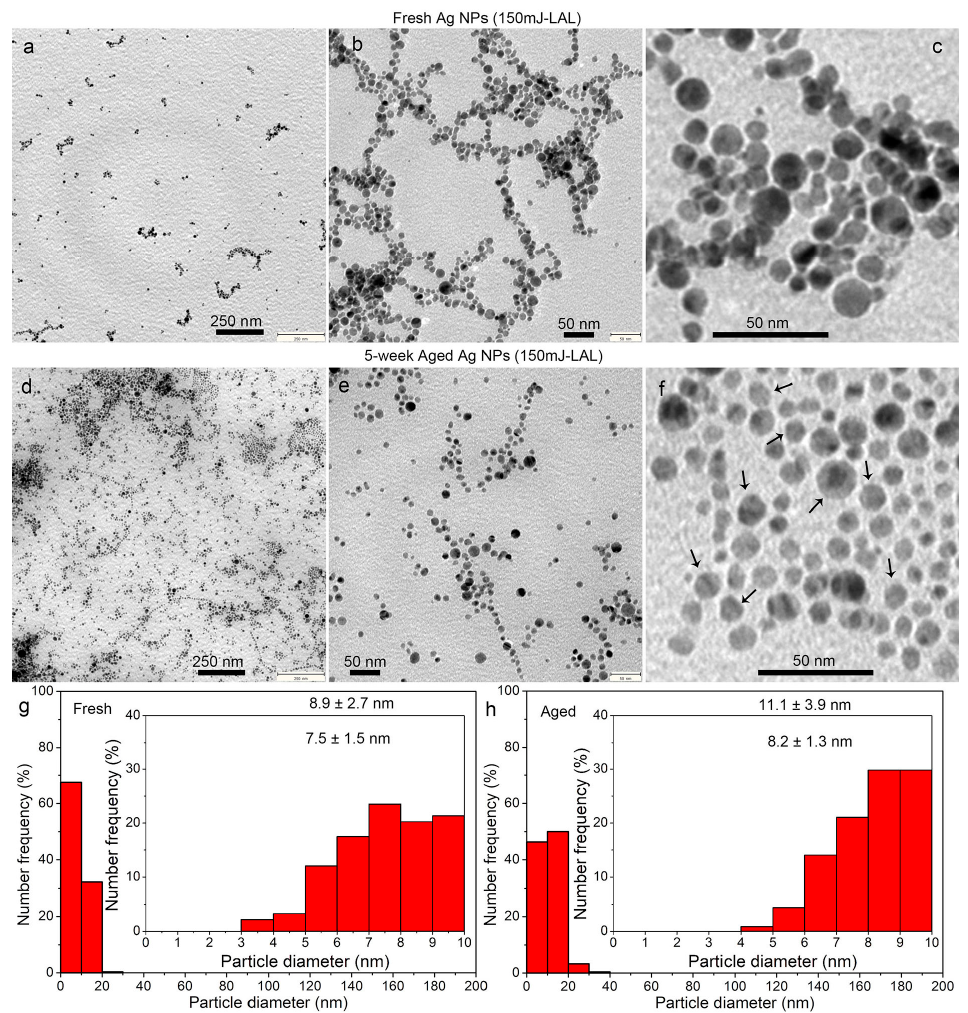
Figure 12. TEM images ( a – f ) and sizes distributions ( g , h ) of fresh ( a – c , g ) and five week ( d – f , h ) aged Ag particles synthesized by ns laser ablation of Ag in acetone at a pulse energy of 150 mJ.